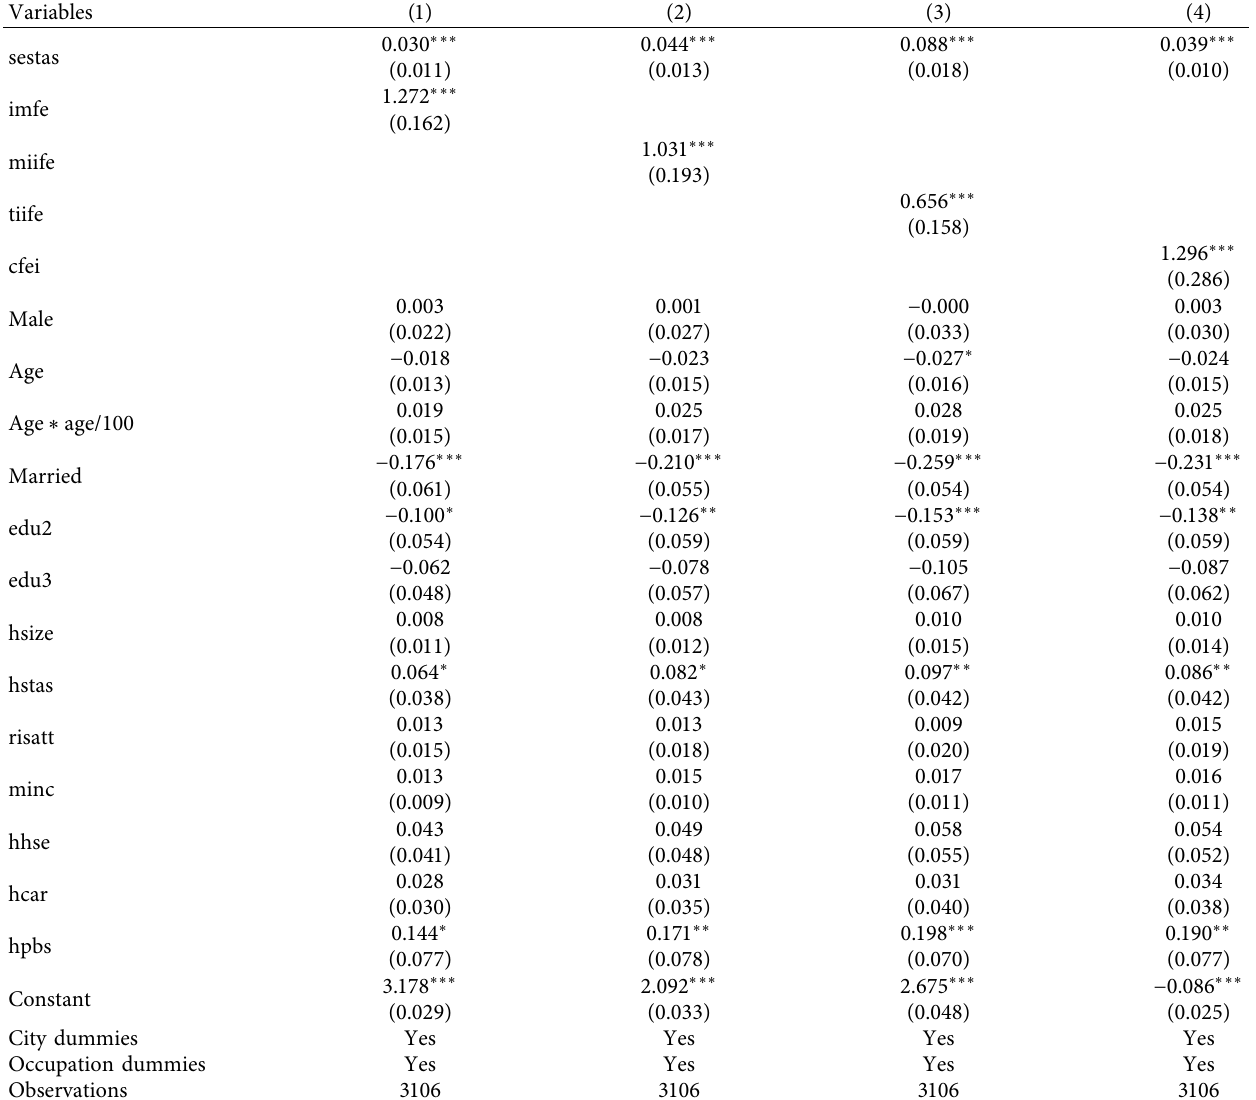
Table 7: Results of the endogeneity